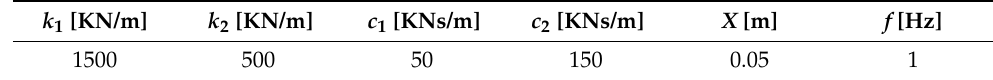
Figure 2. Time histories of forces developed by a vibration isolation system with asymmetric PWL. Table 1. Values of parameters for hysteretic force.